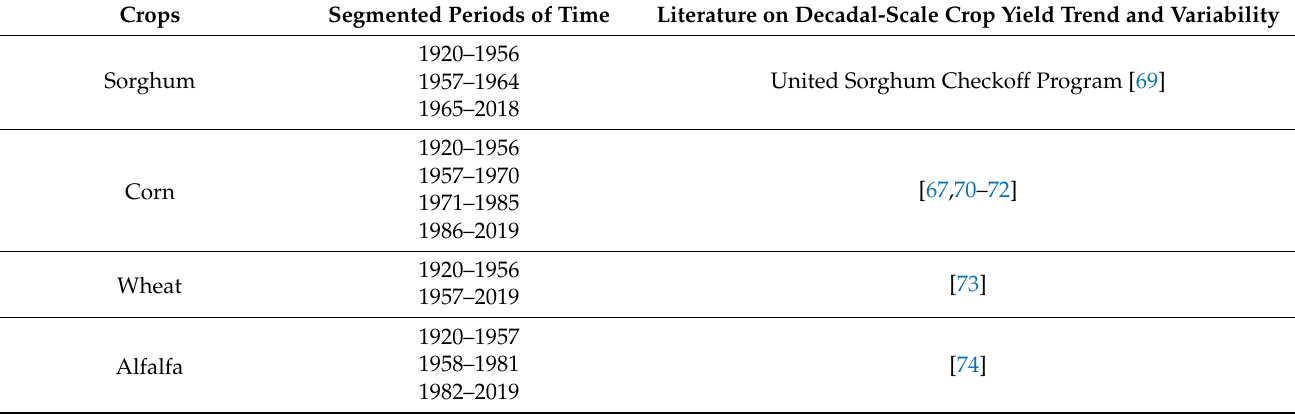
Table 2. Decadal-scale crop yield trends and variability of four crop types.